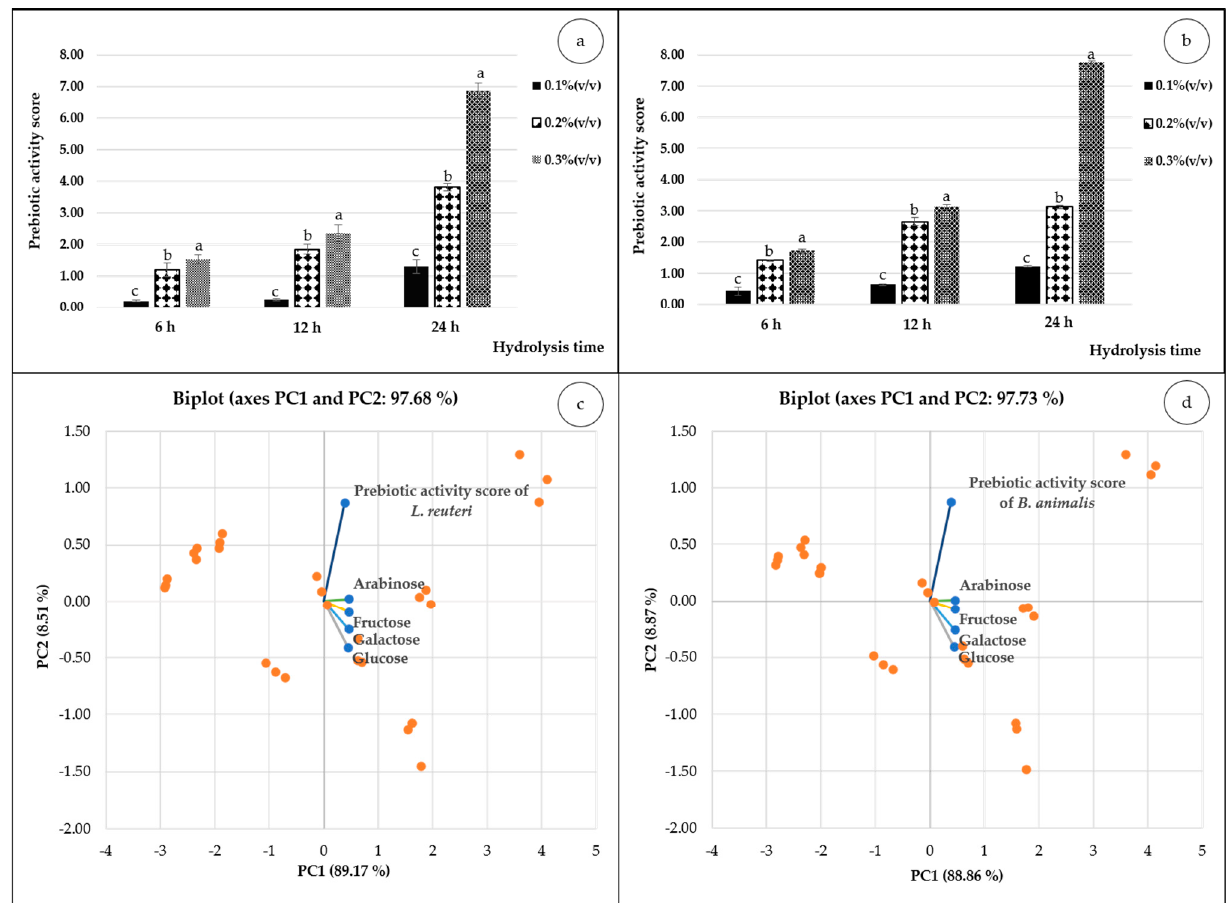
Figure 1. Prebiotic activity scores of MPOS obtained from MPP hydrolysed using various concentrations of pectinase (0.1, 0.2, 0.3% ( v/v )) at different hydrolysis times (6, 12, 24 h) of L. reuteri DSM 17938 ( a ) and B. animalis TISTR 2195 ( b ). Different letters on the bars in the same hydrolysis times indicate statistically significant differences ( p < 0.05). The chemometric PCA of monosaccharide compositions and prebiotic activity scores of L. reuteri DSM 17938 ( c ) and B. animalis TISTR 2195 ( d ).